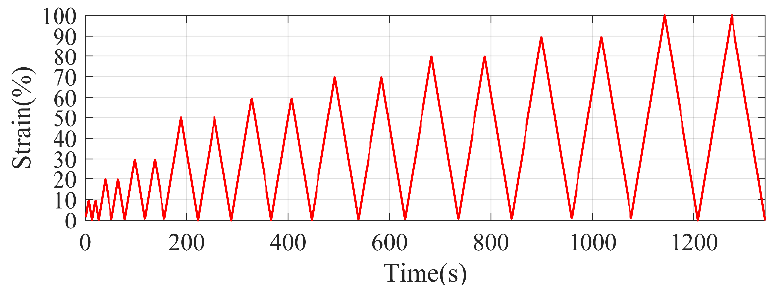
Figure 4. Loading pattern for cyclic test.